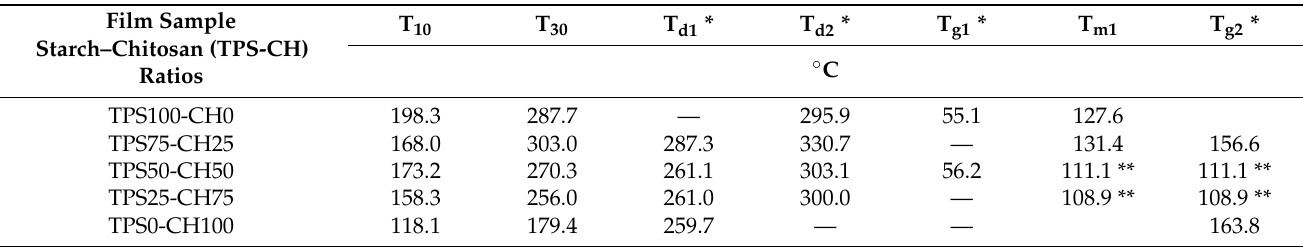
Table 2. Weight losses of 10% (T 10 ), weight losses of 30% (T 30 ), maximum degradation (T d1 ), maximum degradation (T d2 ), glass transition (T g ), and melting (T m ) temperatures. Results are based on the obtained thermogravimetric analysis (TGA) and differential scanning calorimetry (DSC) thermograms for the starch-chitosan (TPS-CH) biodegradable films. Film